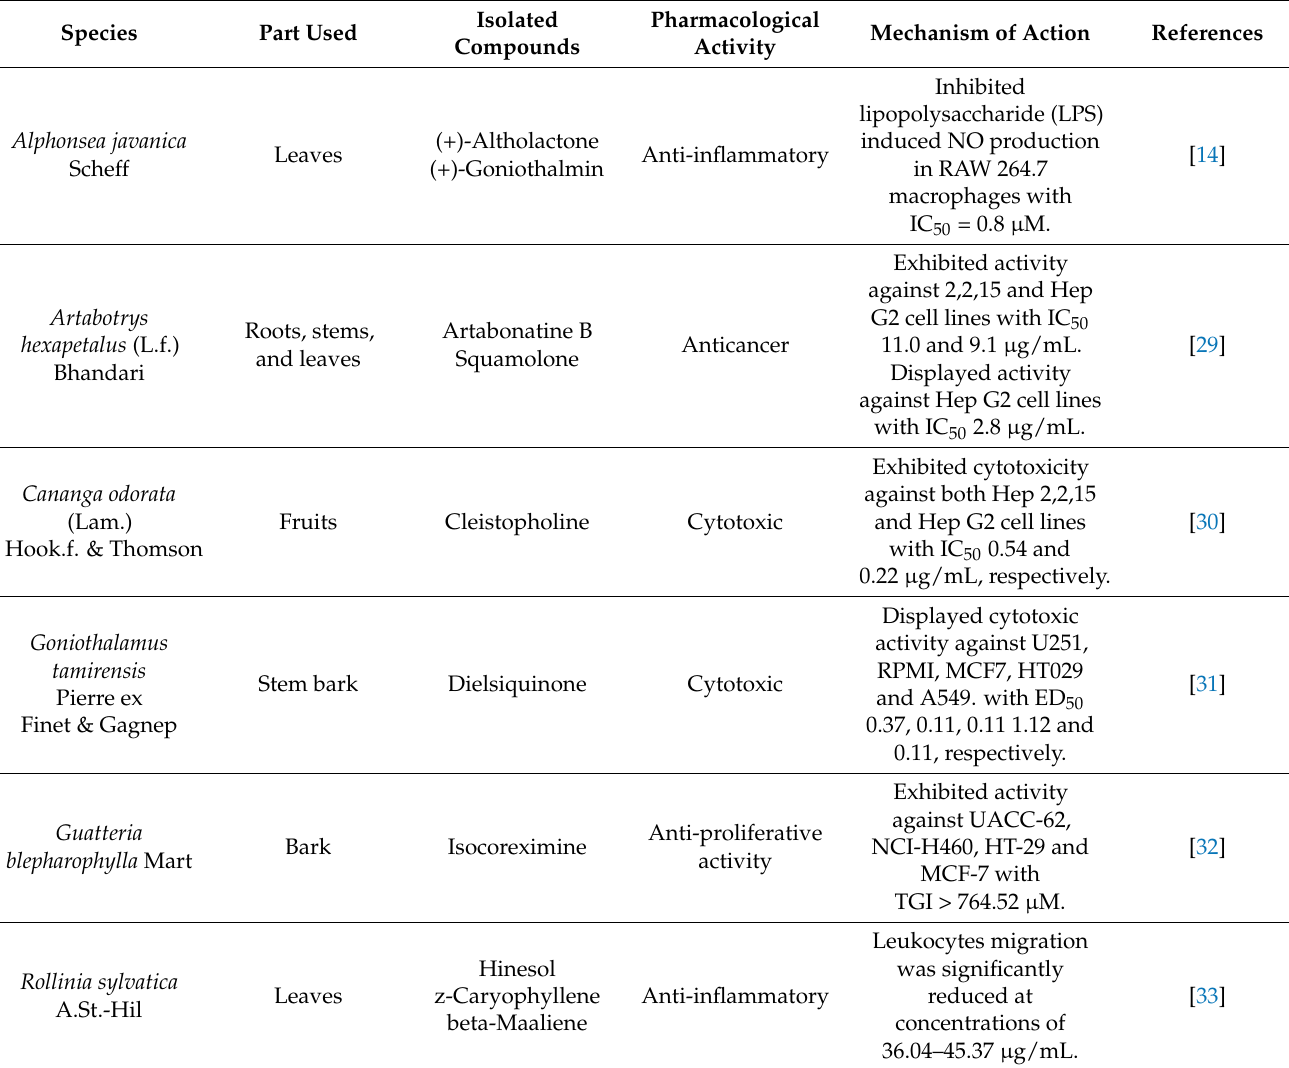
Table 3. Pharmacological activities of some isolated compounds from Annonaceae